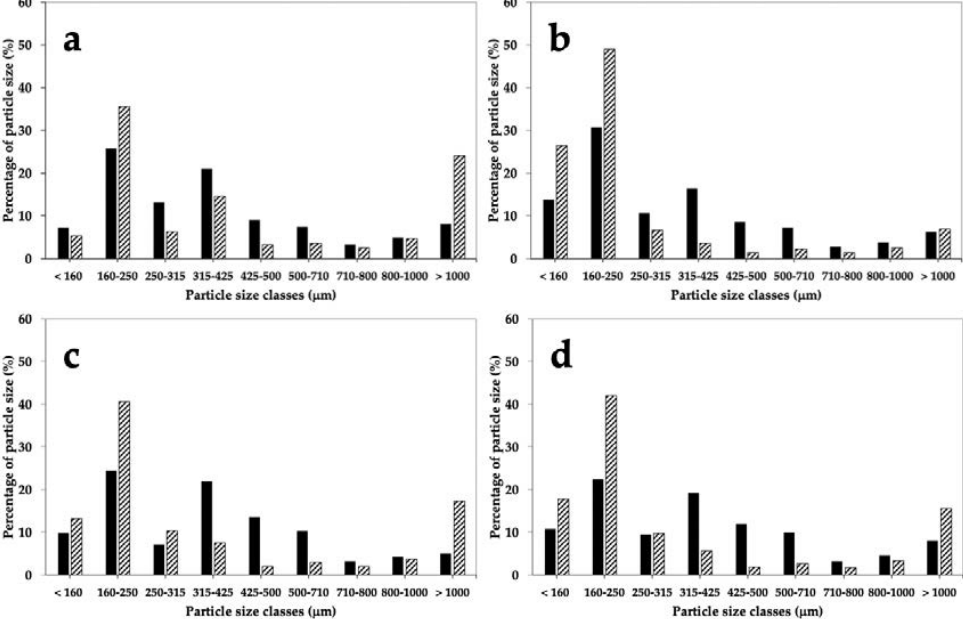
Figure 1. Effect of stone milling (black bars) and roller milling (dash bars) on the particle size distribution of whole grain flours from Bolero cv ( a ), CWRS ( b ), Bona Vita cv ( c ) and Skorpion cv ( d ). CWRS: commercial Canada Western Red Spring Wheat.